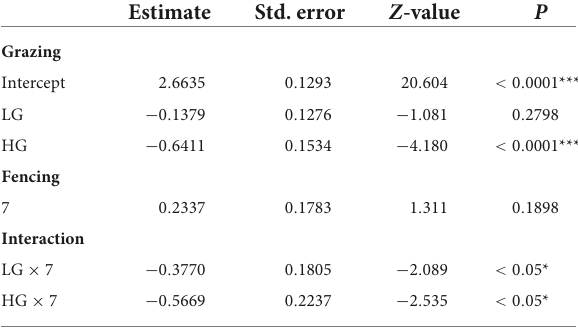
TABLE 3 Results of generalized linear mixed models (GLMMs) for species richness of insects sampled after 3 or 7 fencing years in three grazing treatments in a desert steppe: Ungrazed plot (CK, used as reference), light grazed (LG), and heavily grazed (HG). Estimate Std. error